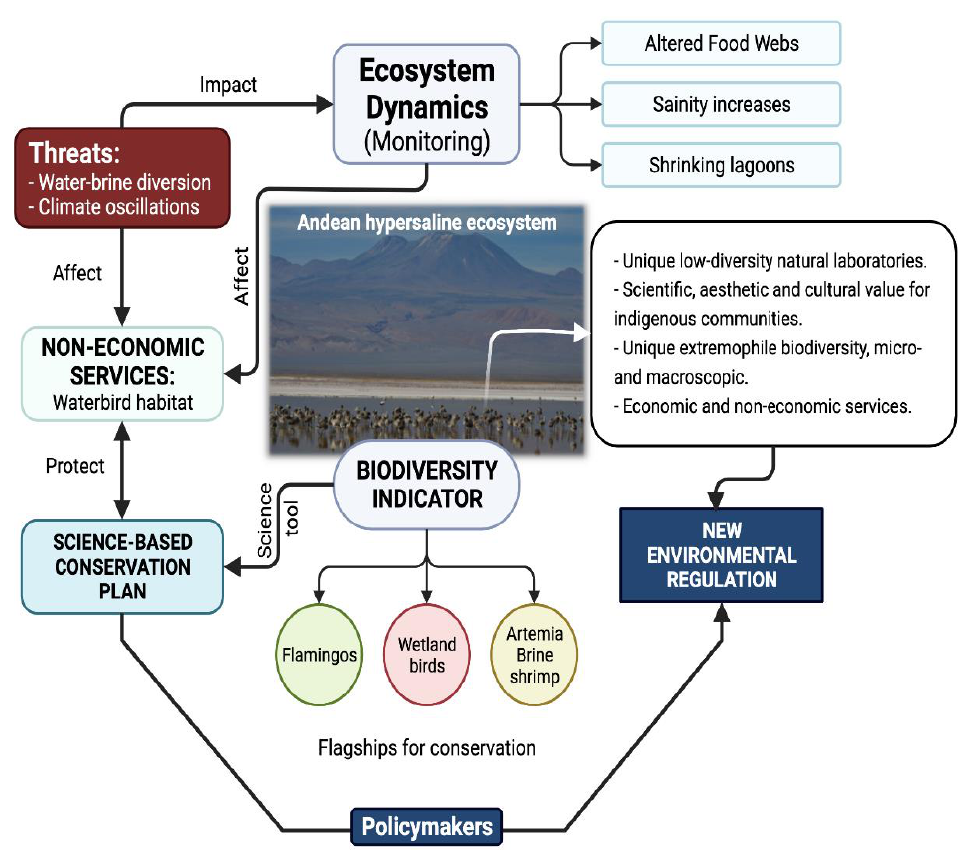
Figure 3. A conceptual framework for conserving Andean high-altitude hypersaline lagoons, biodiversity, and non-economic services (waterbird biodiversity) that are affected by climate oscillations, increasing lithium extraction from brine, and freshwater diversion. Flamingos, other waterbirds, and the brine shrimp Artemia are flagships for conservation. A transdisciplinary approach involving non-scientific stakeholders, including policymakers, lithium companies, and indigenous communities, should help to articulate the scientific knowledge with these stakeholders to produce a validated science-based conservation plan and environmental regulations. Figure modified from [37].